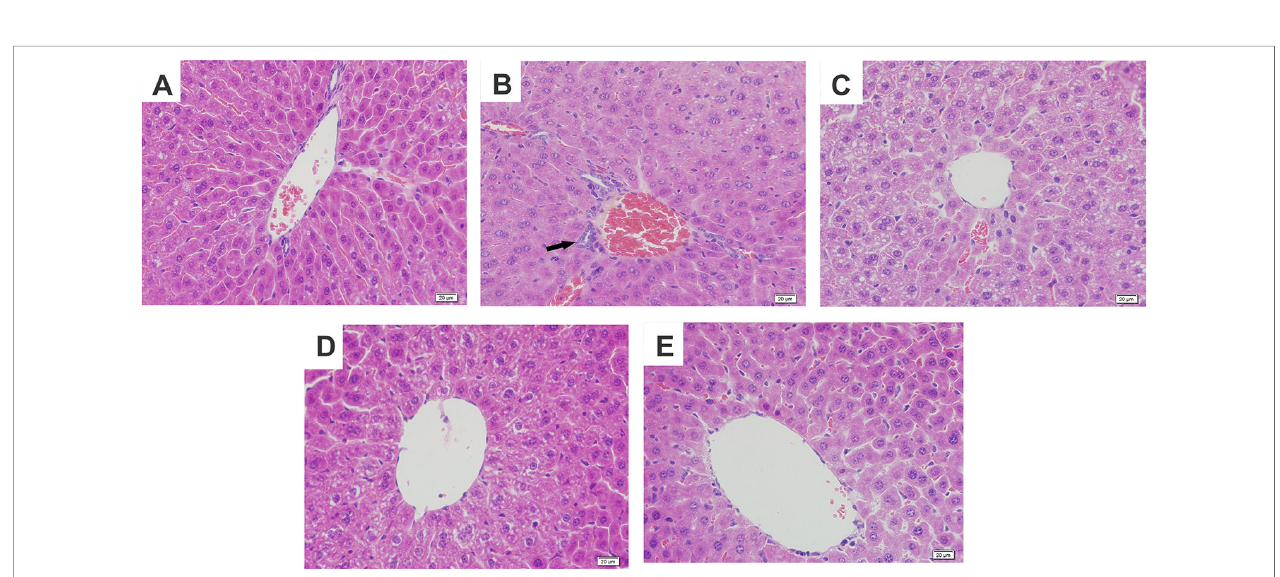
FIGURE 2 | Effects of magnolol on histopathological changes of liver tissues in alcohol-induced liver damage. (A) Control. (B) Alcohol. (C) Alcohol + magnolol (5 mg/kg). (D) Alcohol + magnolol (10 mg/kg). (E) Alcohol + magnolol (20 mg/kg). The black arrow in (B) represents in fl ammatory cell in fi